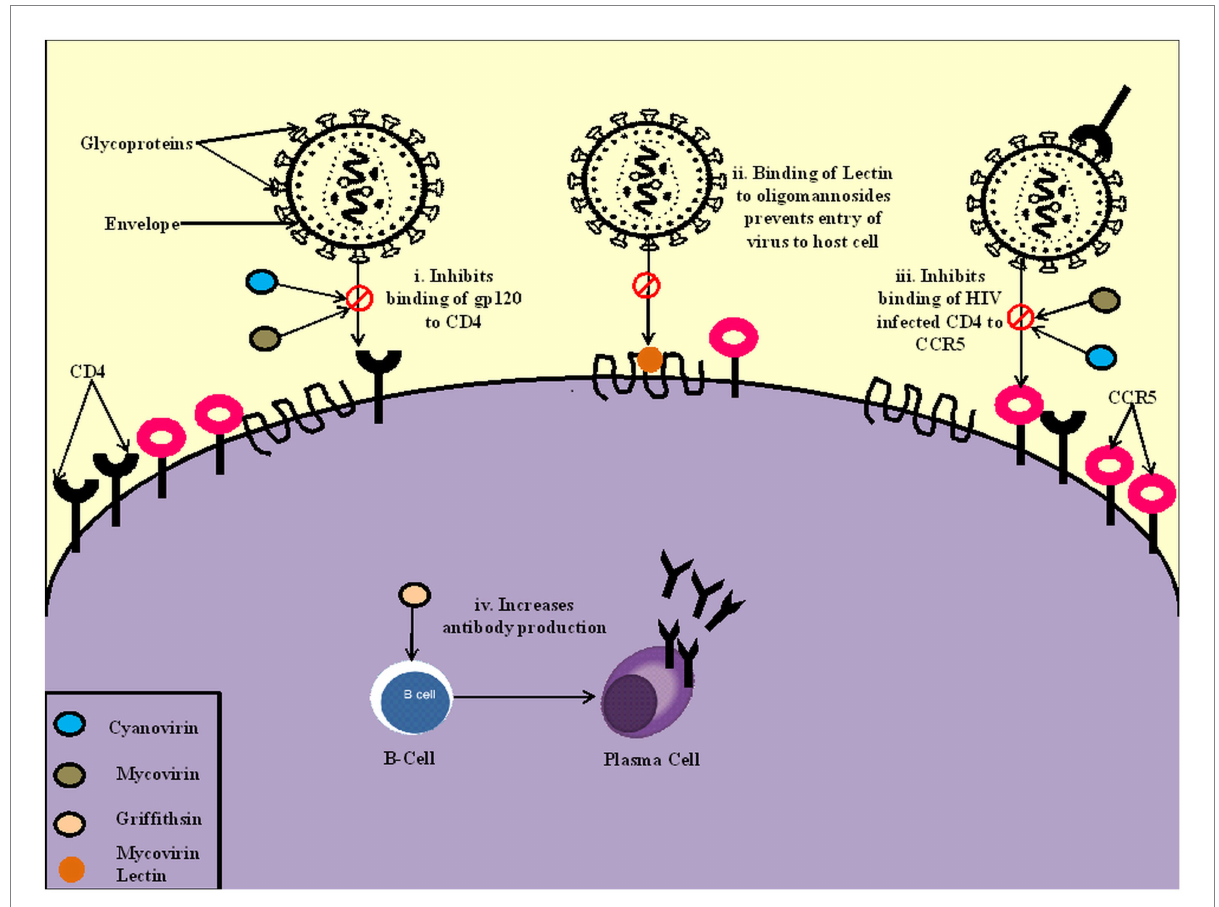
FIGURE 2 Mechanism of action of cyanobacteria on the virus. (i). Cyanovirin and Mycovirin inhibit the binding of a glycoprotein gp120 to CD4 cells, preventing the viral infection (ii). Mycovirin Lectin binds to oligomannosides on the cell wall, blocking the virus’s entry to the host cell (iii). Cyanovirin and Mycovirin block the binding of CD4 infected cells to CCR5 receptors, which prevents the progression of infection (iv). Griffithsin increases the production of antibodies and increases the reactivity of